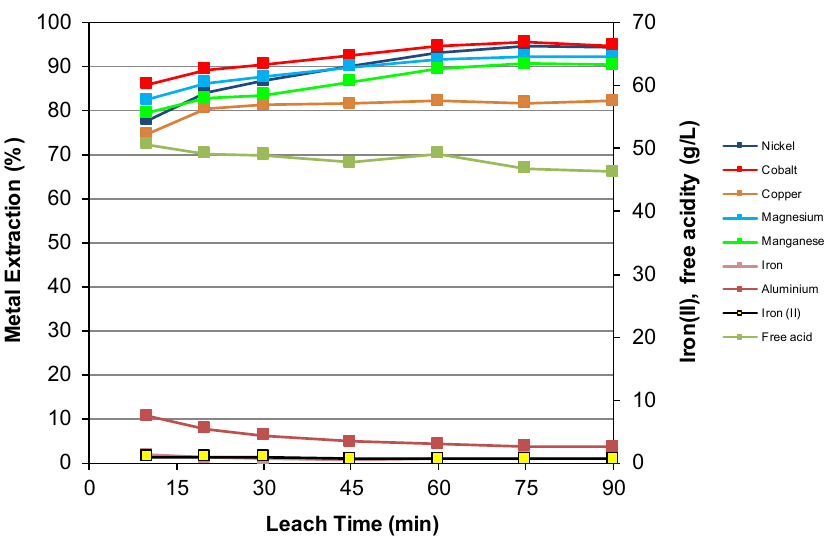
Figure 1. Metal extractions, ferrous iron concentration and free acidity for samples taken during the high pressure acid leaching (HPAL) of 30% w/w blended nickel laterite ore in site water at 250 °C using 364 kg/t dry ore acid addition.